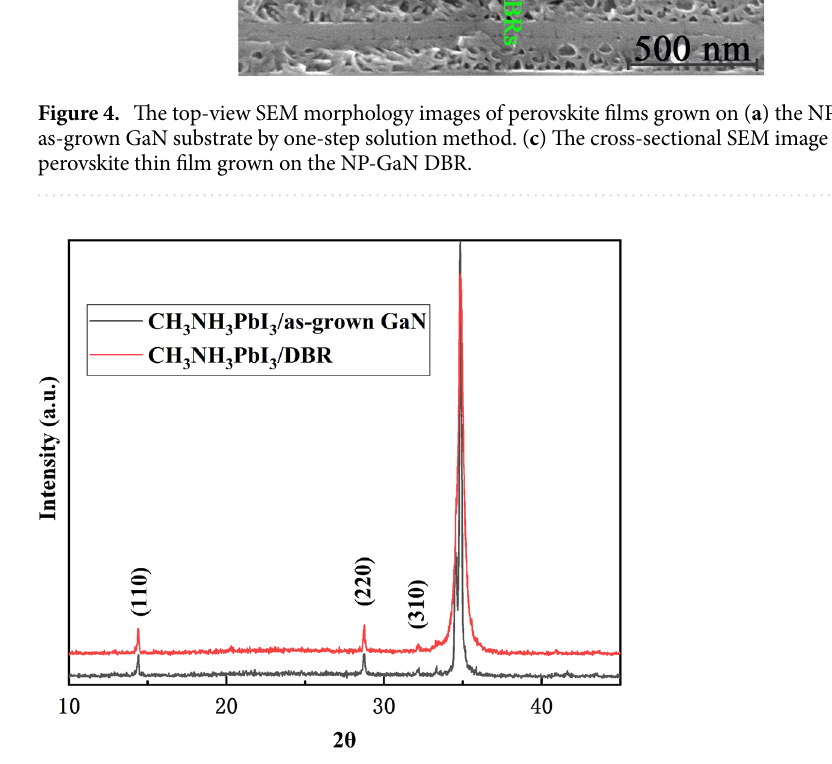
Figure 5. The XRD patterns of the perovskite thin films grown on the NP-GaN DBR and as-grown GaN